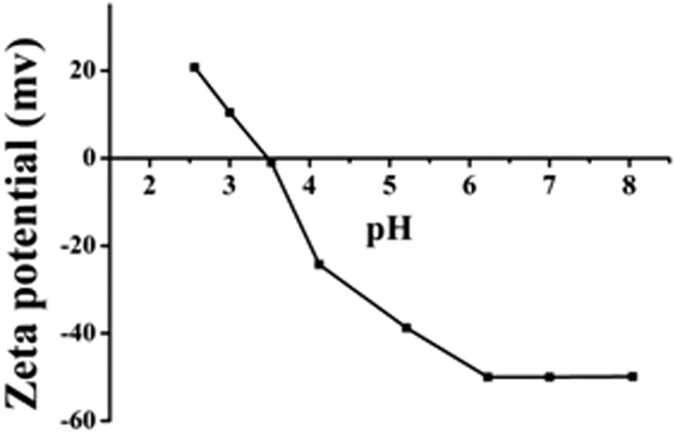
Zeta-potential at different pH of Fe3O4 NPs.